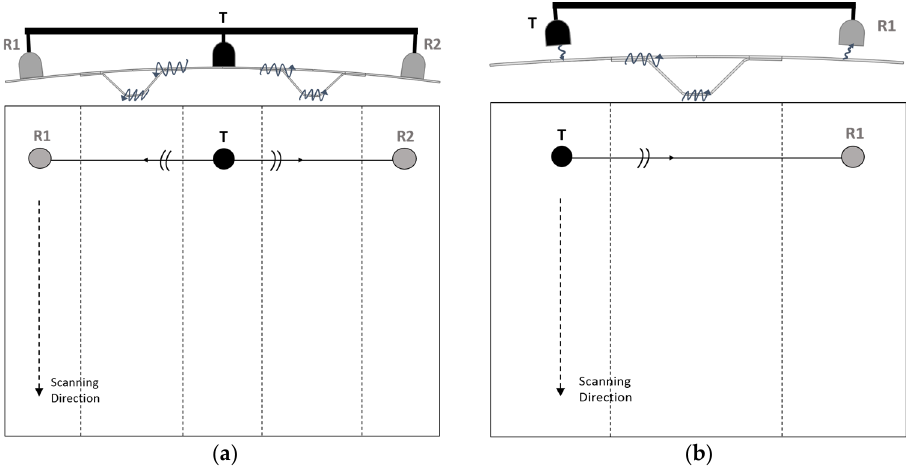
Figure 4. Line scanning approach for ( a ) a contact system and ( b ) a non-contact system; cross-sectional view (top drawings) and front view (bottom drawings).